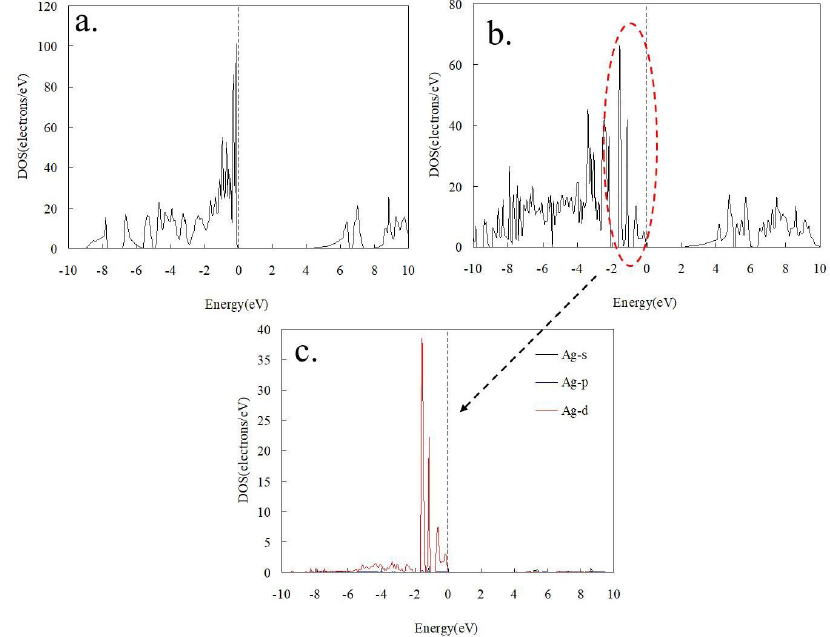
(a), ANS Catalyst (b) and pDOS of Ag atom in ANS Catalyst (c). 3